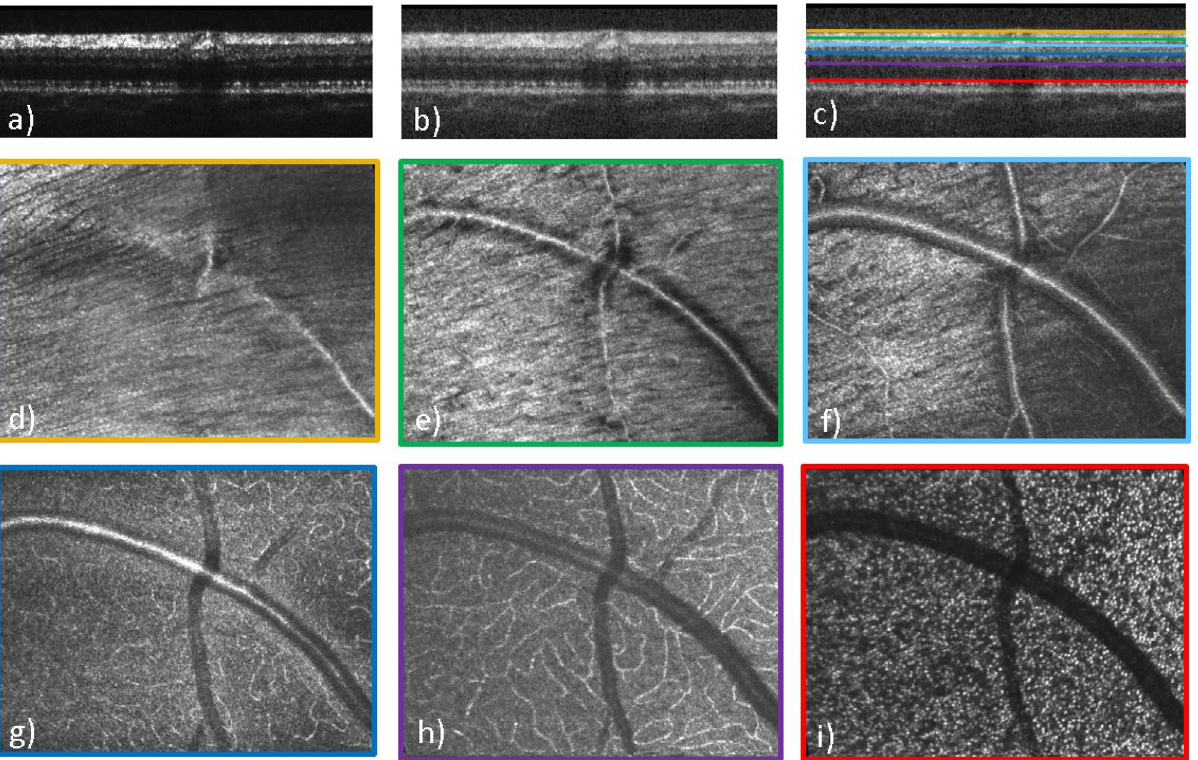
Figure 5. AO-OCT B-scan ( a – c ) and en-face images of different layers ( d – i ) recorded with a field of view of 4° × 3°. ( a ) B-scan in linear scale, ( b ) B-scan in log scale, ( c ) color-coded lines indicating the location of the corresponding en-face layers in B-scan, ( d ) inner limiting membrane, ( e ) nerve fiber layer, ( f ) superficial vascular plexus layer, ( g ) mid vascular plexus layer, ( h ) deep vascular plexus layer, ( i ) inner/outer segment junction Fig. 4c,d were recorded at two different locations centered at ~ 4-degree eccentricity from the fovea and focused on the nerve fiber layer and the photoreceptor layer, respectively. The nerve fiber bundles and fine vascular details such as capillaries and vessel walls in the nerve fiber layer can be distinguished. Figure 4f,h are the enlarged view (× 4) of photoreceptor cone mosaic features at ~ 3° eccentricity from fovea. At this eccentricity from the fovea,